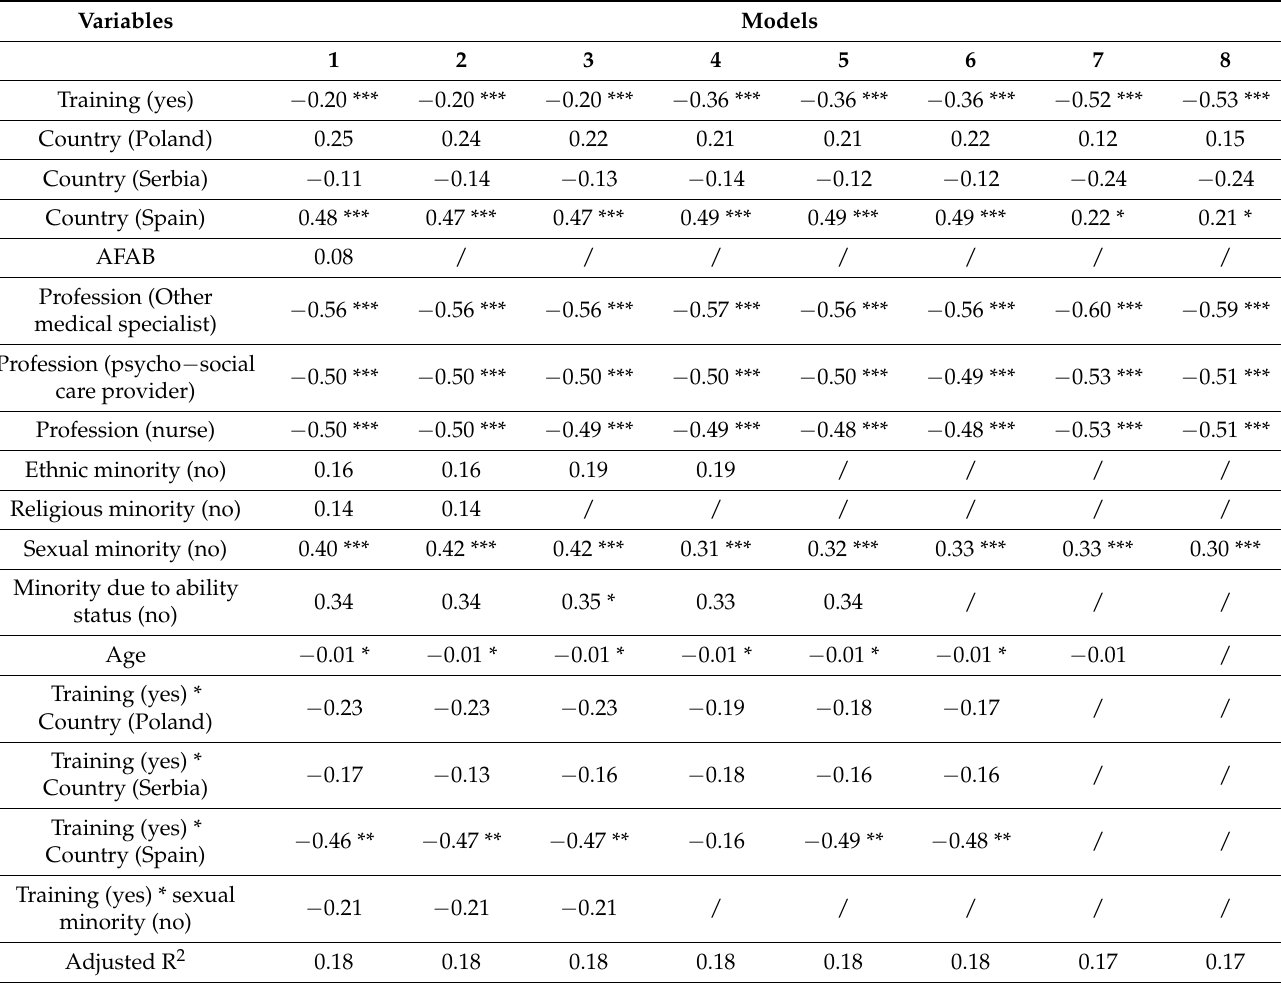
Table 5. Regression analysis for level of confidence (standardized regression